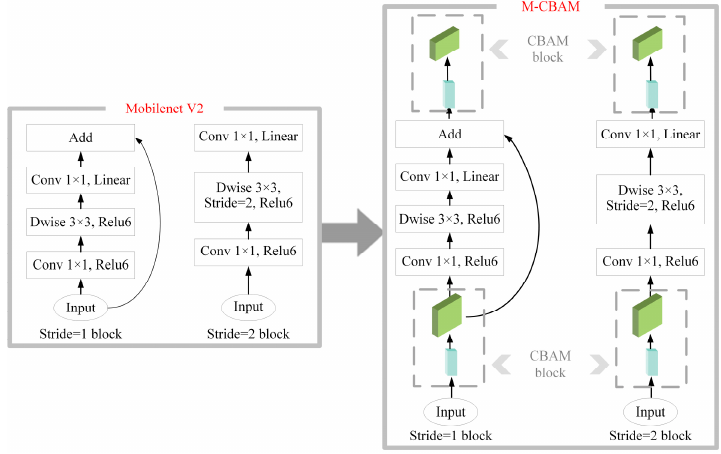
Figure 8. The optimization of the MobileNetV2 network.